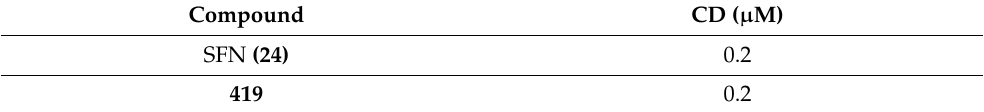
Table 10. Effect of SFN and its analogue 419 on the inducer potency for QR in Hepa 1c1c7.